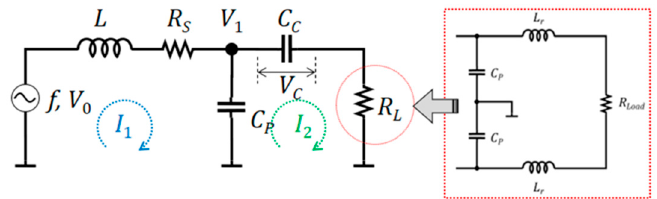
Figure 4. Simplified circuit model for system analysis.